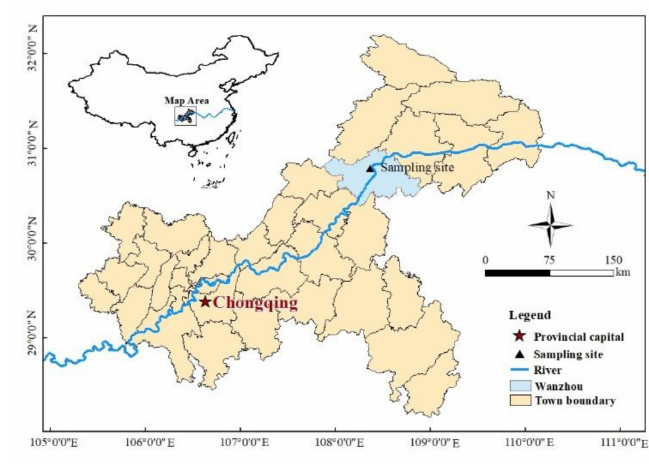
Figure 1. Location of sampling site.